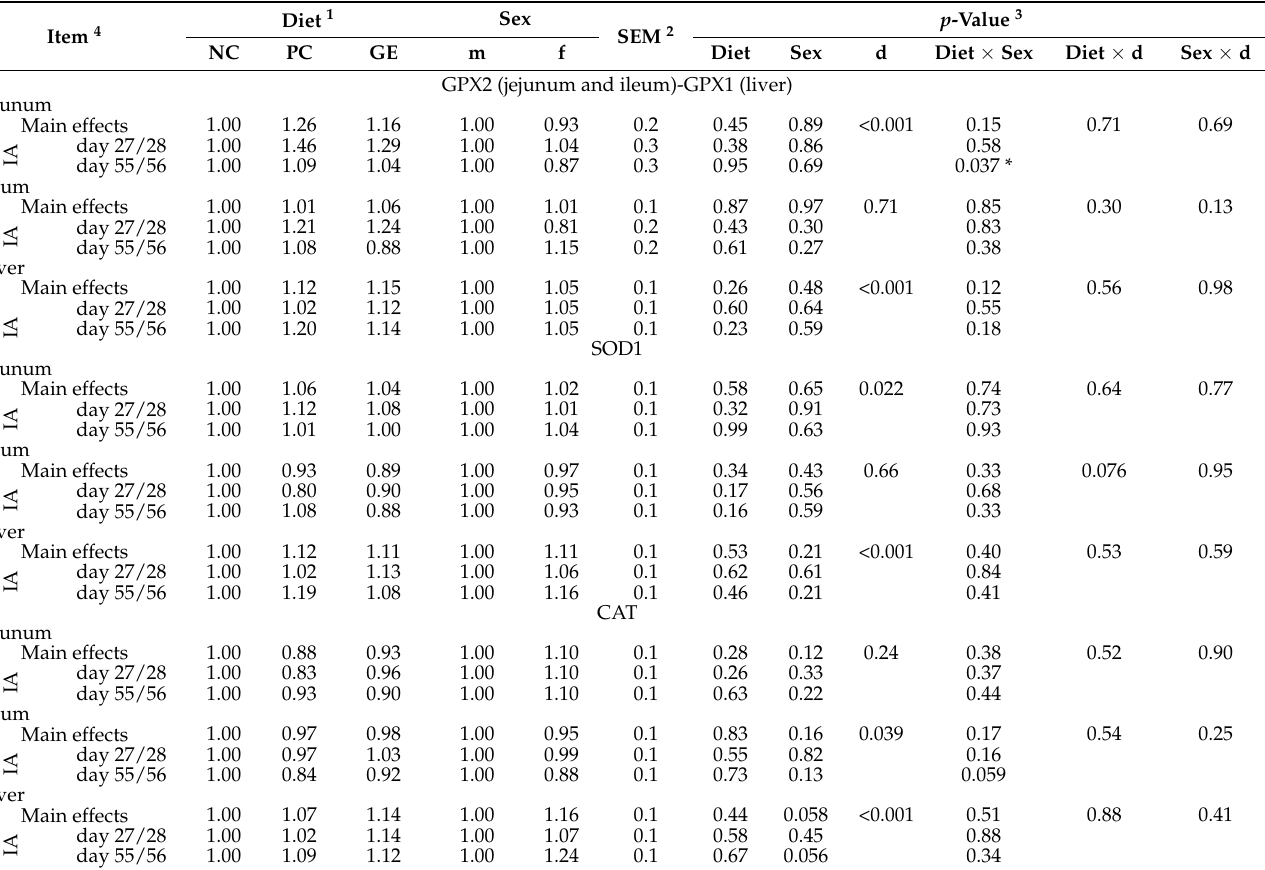
Table 7. Expression of selected marker genes of oxidative stress in the intestinal tissue and liver of weaning piglets fed GE compared to NC and PC. NC was set to 1.0.